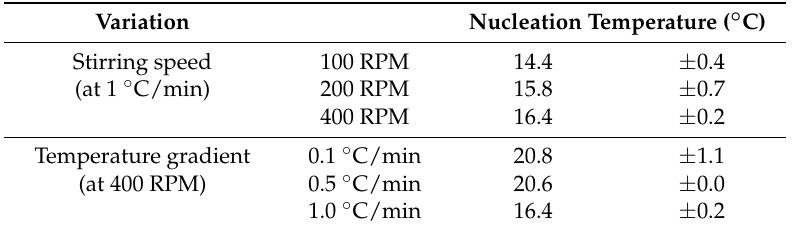
Table 1. Influences of stirring speed and temperature gradient on measured metastable zone width.